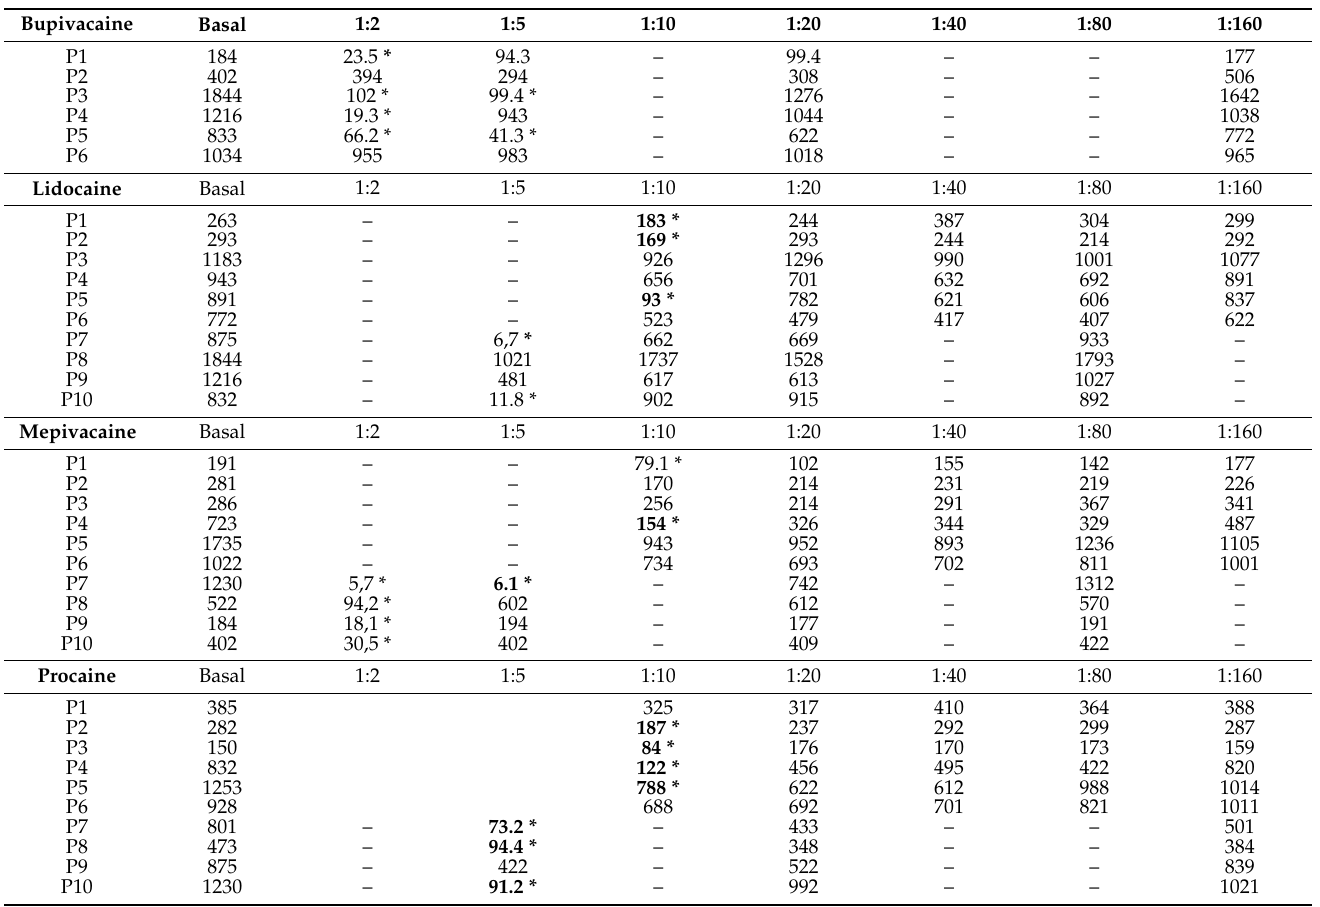
Table 5. Dilution series to determine the non-cytotoxic dilution of the tested four LAs. * = cytotoxic effects found in trypan-blue staining microscopy. No cytotoxic effects, but inhibition was seen in dilutions of 1:20 and higher in all of the LAs tested.